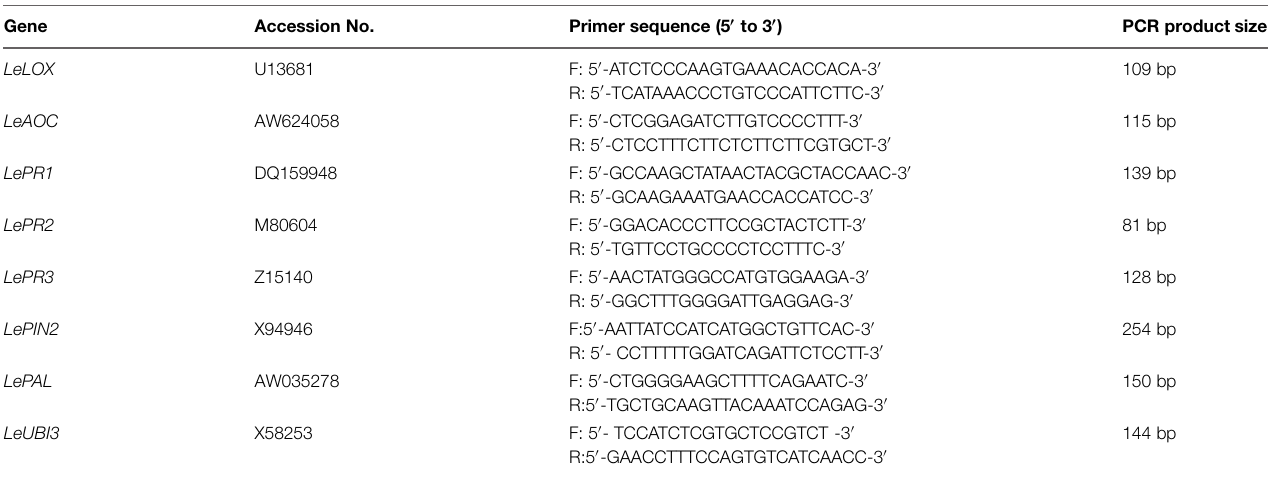
TABLE 1 | Specific primer for real-time